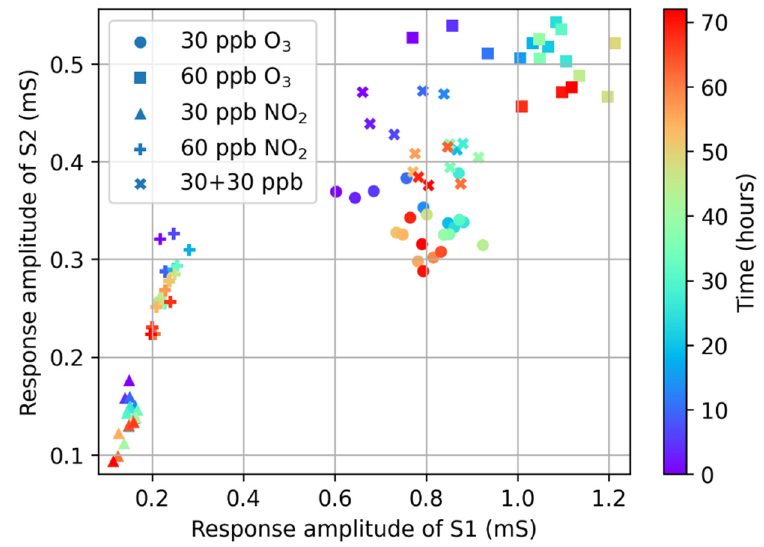
Figure 9. A diagram from Figure 7, redrawn so that the color indicates the time passed since the start of the experiment.